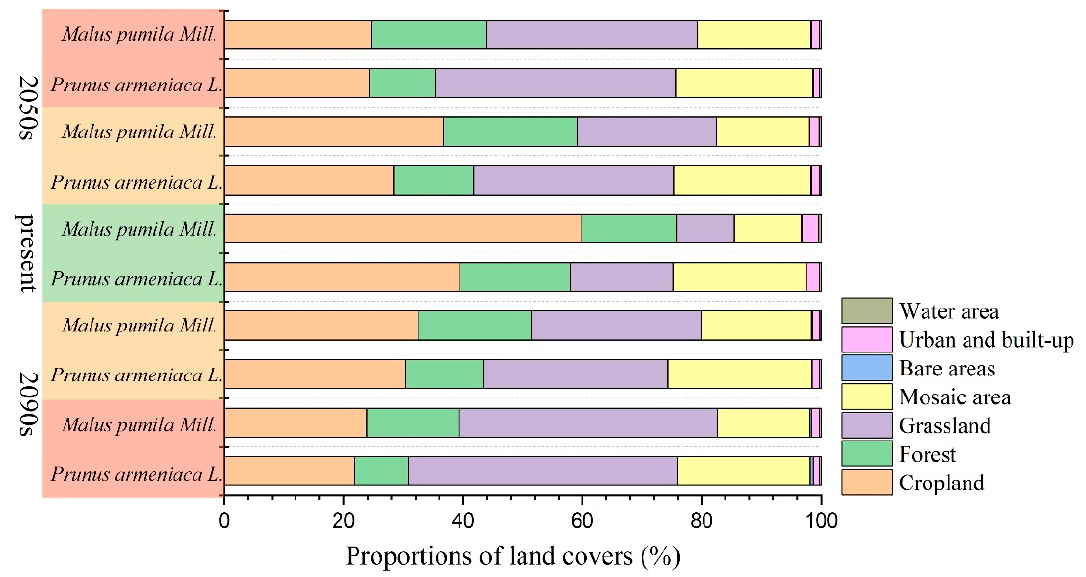
Figure 7. Proportions of land cover in the Loess Plateau under different climate scenarios. Species shaded in light green show the present condition, species shaded in light orange show the conditions of the Shared Socioeconomic Pathways (SSPs) SSP1-26 and species shaded in deep pink show the conditions of SSP5-85.